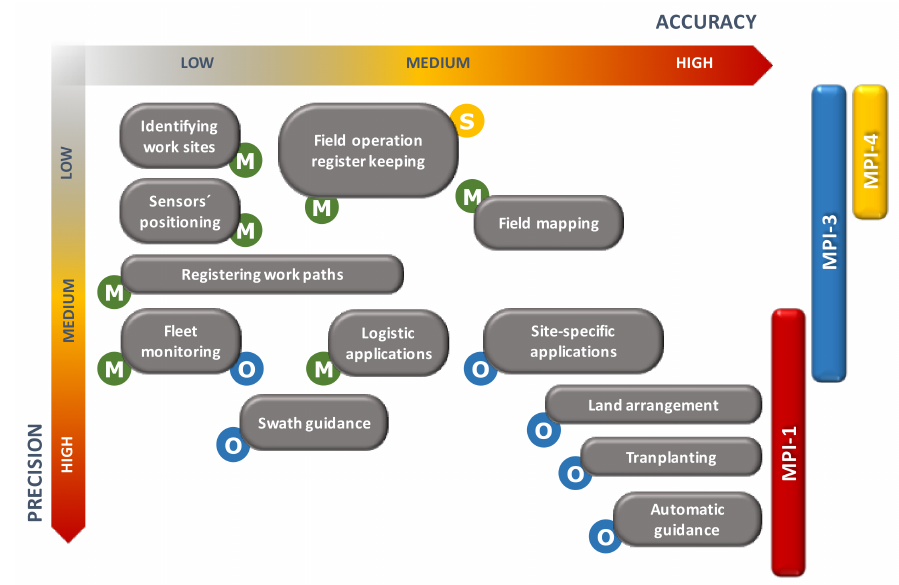
Figure 10. Accuracy and precision requirements for GNSS receivers to be used in di ff erent agricultural applications. The main decision-making levels and MPIs involved are also indicated. For the symbols, refer to Figure 6. As quantitative reference, the following range values can be considered: ( a ) LOW: > 20 m; ( b ) MEDIUM: 2–5 m; ( c ) HIGH: < 0.05 m